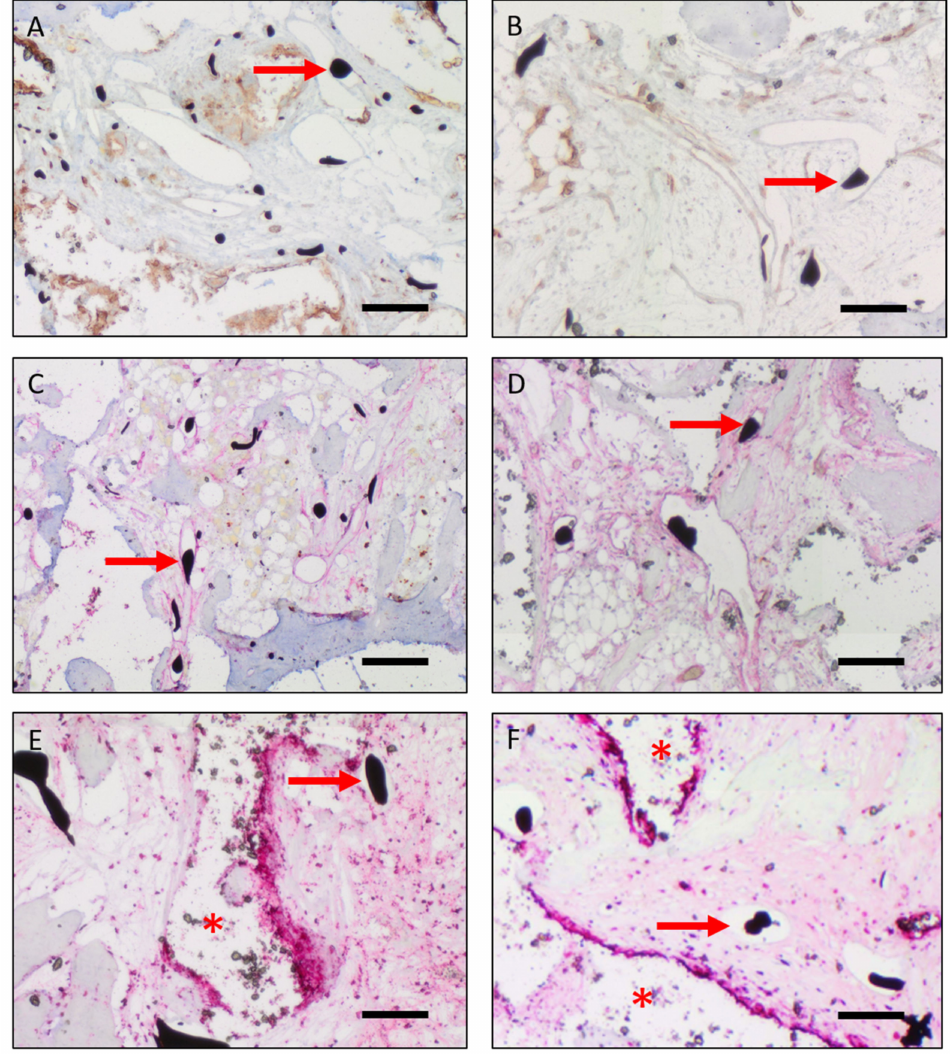
Figure 5. Representative immunohistochemical staining of constructs of group C ( A , C , E ) and C irrad ( B , D , F ). (( A , B ): Lectin staining; ( C , D ): alpha-smooth muscle actin staining; ( E , F ): CD68 staining). ( A – D ): Vessel lumina filled with Microfil ® (black dots, red arrows) were lectin and alpha-smooth muscle actin positive in groups C and C irrad. ( E , F ): In groups C and C irrad, there were CD68 positive cells around the granule detectable. (Arrows: Microfil ® inside the vessel lumen; Asterisk: degraded scaffold). Scale bar 0.2 mm. Total magnification ×